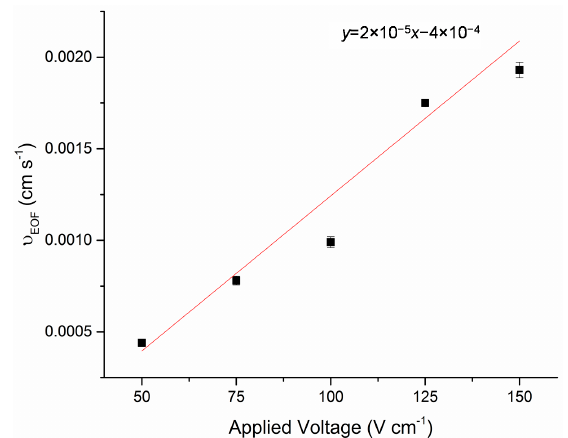
Figure 2. Graph showing the EOF velocity of the TE buffer used in the DNA purification process. Error bars represent the standard deviation of the triplicate analysis performed on three separate microfluidic devices.